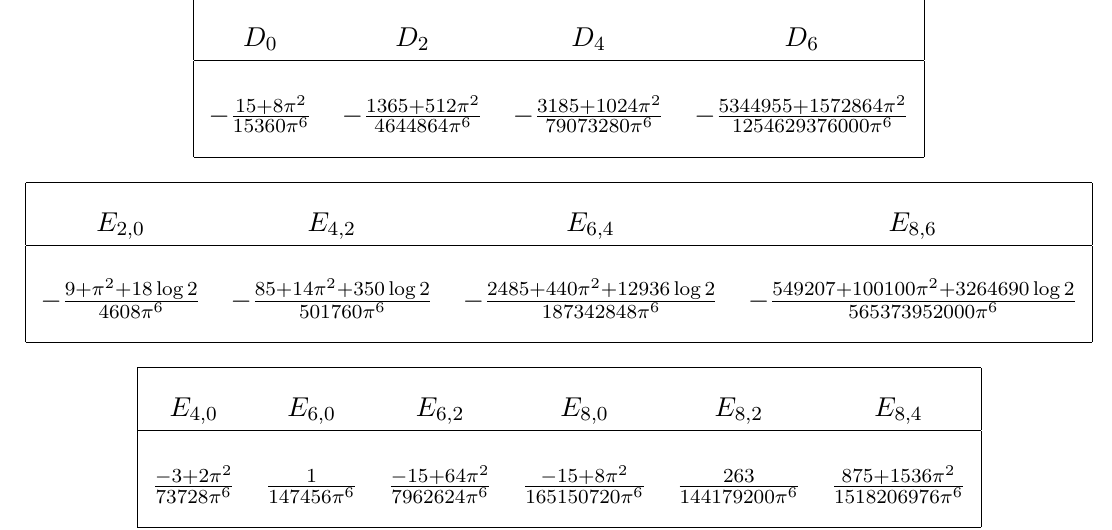
Table 2. Bulk CFT data coefficients D l and E ∆ ,l for low spin l := 2 j at NLO. Only the longs with even ∆ are non-vanishing. The second line shows the CFT data for the longs at the unitarity bound ∆ = l + 2 . Note that all the values should be multiplied by g 8 N 2 . Values up to l = 16 can be found in the ancillary Mathematica file of the supplementary